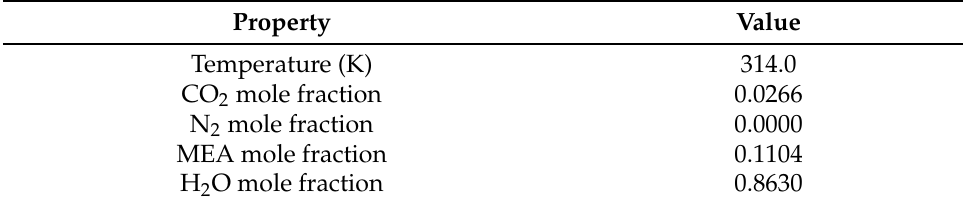
Table 4. Nominal inlet amine solvent